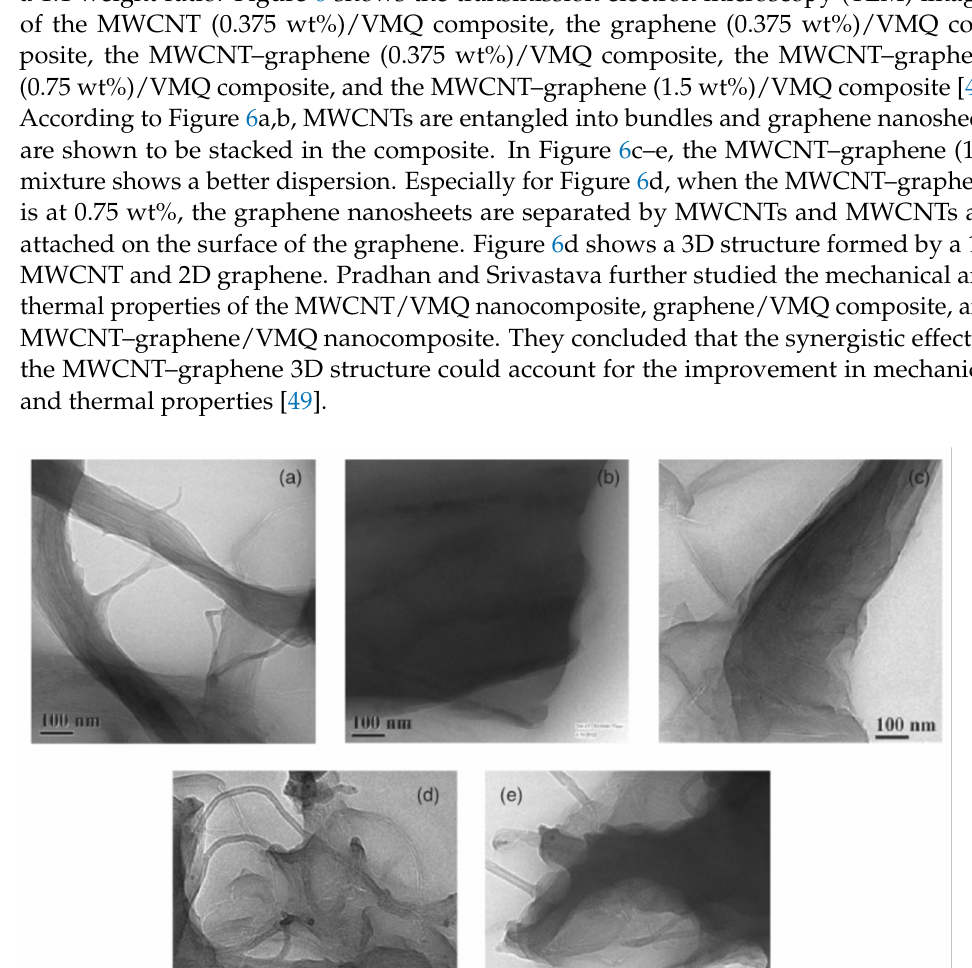
a 1:1 weight ratio. Figure 6 shows the transmission electron microscopy (TEM) images of the MWCNT (0.375 wt%)/VMQ composite, the graphene (0.375 wt%)/VMQ com- posite, the MWCNT–graphene (0.375 wt%)/VMQ composite, the MWCNT–graphene (0.75 wt%)/VMQ composite, and the MWCNT–graphene (1.5 wt%)/VMQ composite [49].